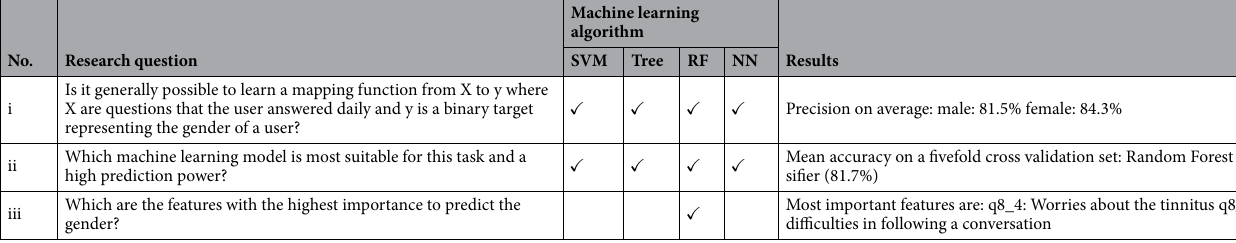
Table 1. Overview of the three Research Questions i-iii , the used classifiers and the results. SVM = Support Vector Machine, Tree = Decision Tree, RF = Random Forest, NN = Multilayer Perceptron Neural Network. A checkmark means that this classifier has been used to answer the research